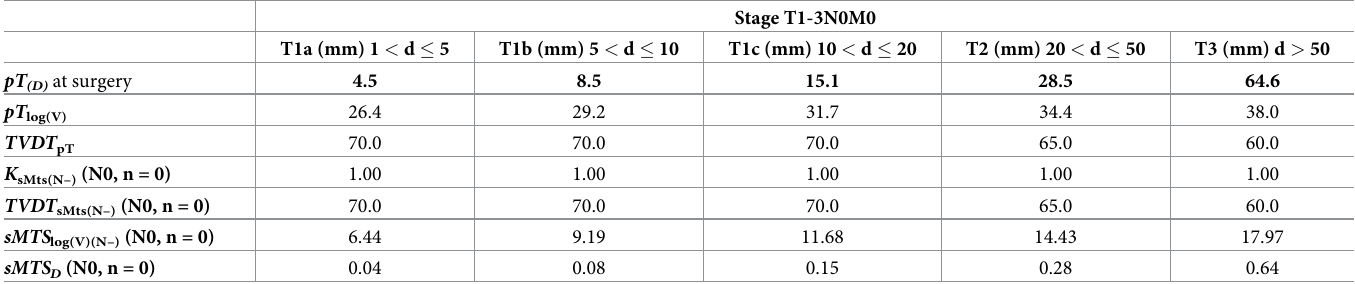
Table 1. The whole natural history of PT and secondary distant MTS growth of BC for different stages (pT1-4N0M0), according to CoMPaS.